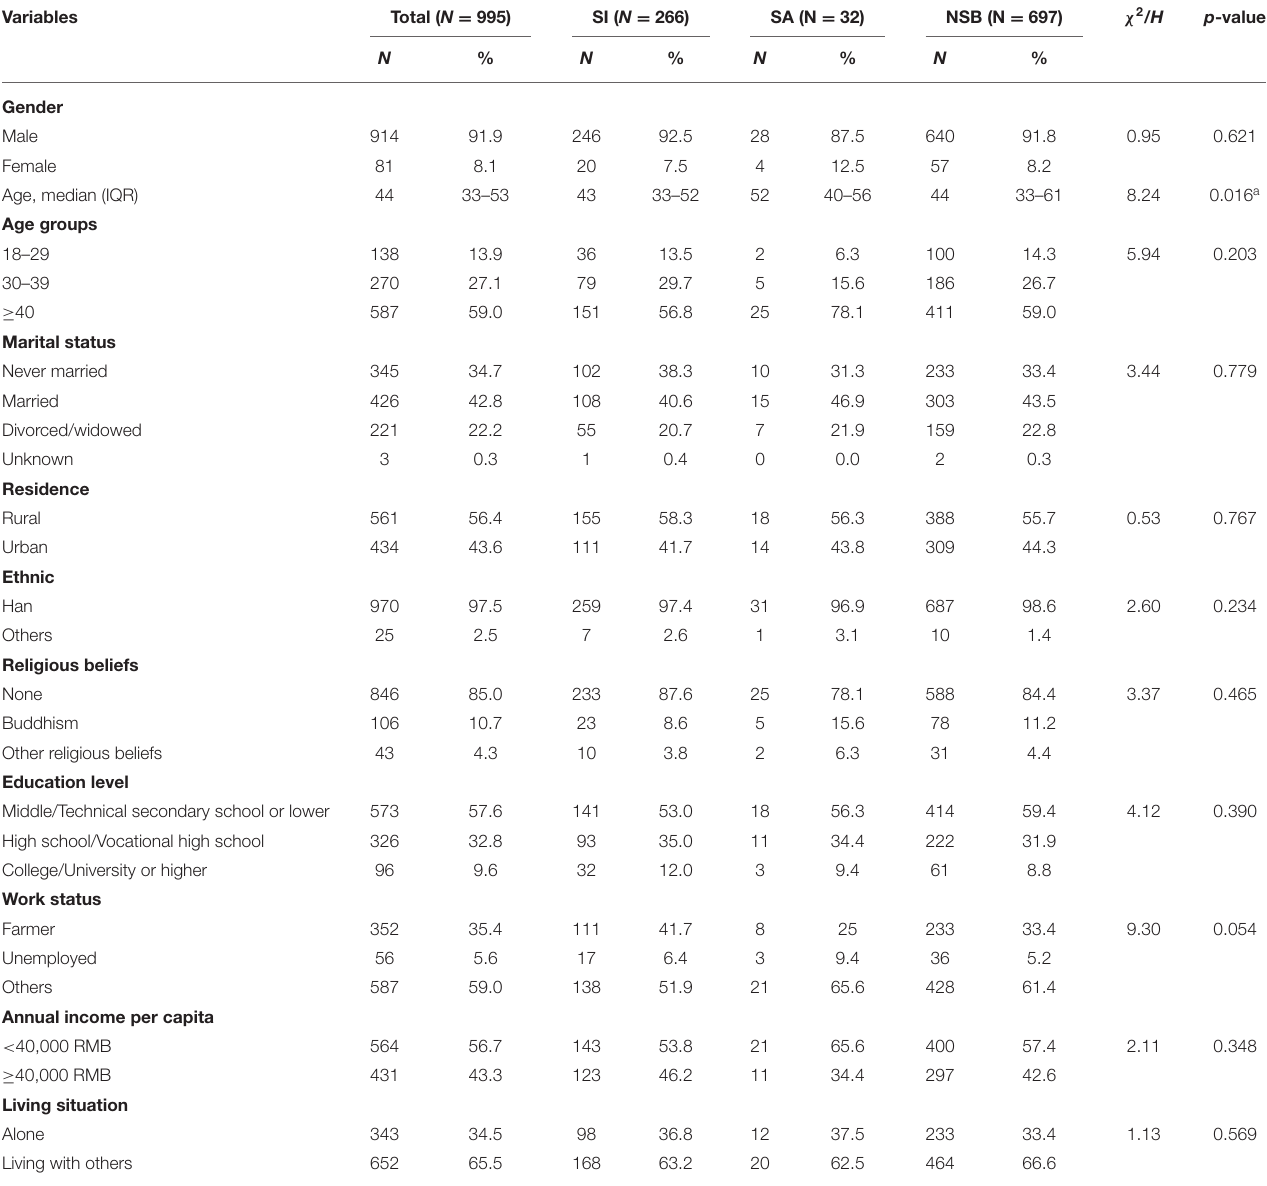
TABLE 1 | The socio-demographic of total samples, Suicidal ideation only (SI), suicide attempt (SA), and without any suicidal behavior (NSB) groups of people living with HIV/AIDS (PLWH).